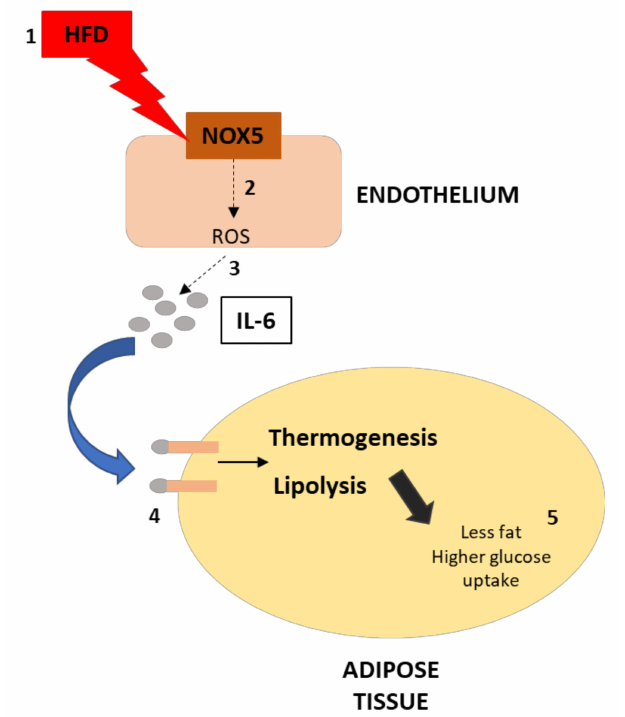
Figure 4. Endothelial NOX5 expression increased IL-6 expression in mesenteric and epididymal fat in mice fed with an HFD for 10 weeks. IL-6 mRNA levels in ( A ) mesenteric fat and ( B ) epididymal fat. Representative Western blots and protein levels of IL-6 in total lysates of ( C ) mesenteric fat and ( D ) epididymal fat. Control diet: control Cre ( n = 12), Nox5/Cre ( n = 11); HFD: control Cre ( n = 10), Nox5/Cre ( n = 12). Results are expressed as mean ± standard error of the mean (SEM). mRNA levels are relative to Gapdh . Protein levels are relative to B-ACTIN. ## p < 0.01: diet differences (dotted lines); * p < 0.05, ** p < 0.01: genotype differences (solid lines). The statistical test used: two-way ANOVA. Figure 10. Graphical scheme of the experimental design and principal findings. ( 1 ) The effect of HFD over endothelial cells increase NOX5 activity, which increases ROS production ( 2 ). This increase in ROS production leads to a higher production of IL-6 in the endothelium ( 3 ). As a consequence, the activity of IL-6 over adipose tissue results in thermogenesis and lipolysis activation ( 4 ). Finally, the upregulation of these processes derives in less fat accumulation and higher glucose uptake of the adipose tissue ( 5 ).